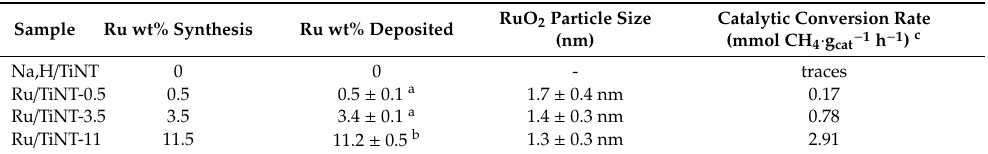
Scheme 1. Pictorial illustration of the synthesis of ruthenium / titanate nanotubes (Ru / TiNTs) starting from TiO 2 anatase. ( i ) Synthesis of Na,H / TiNT by hydrothermal treatment with 10 M NaOH at 150 ◦ C for 6 h. ( ii ) Ru 3 + to Na + and H + ion exchange. ( iii ) Calcination at 200 ◦ C under air. Table 1. Ru content and particle size of the Ru / TiNT samples and their corresponding photothermal catalytic activity. a Ru loading measured with ICP-EOS. b Ru loading measured with EDX. c Reaction conditions: 180 ◦ C and 100 mW / cm 2